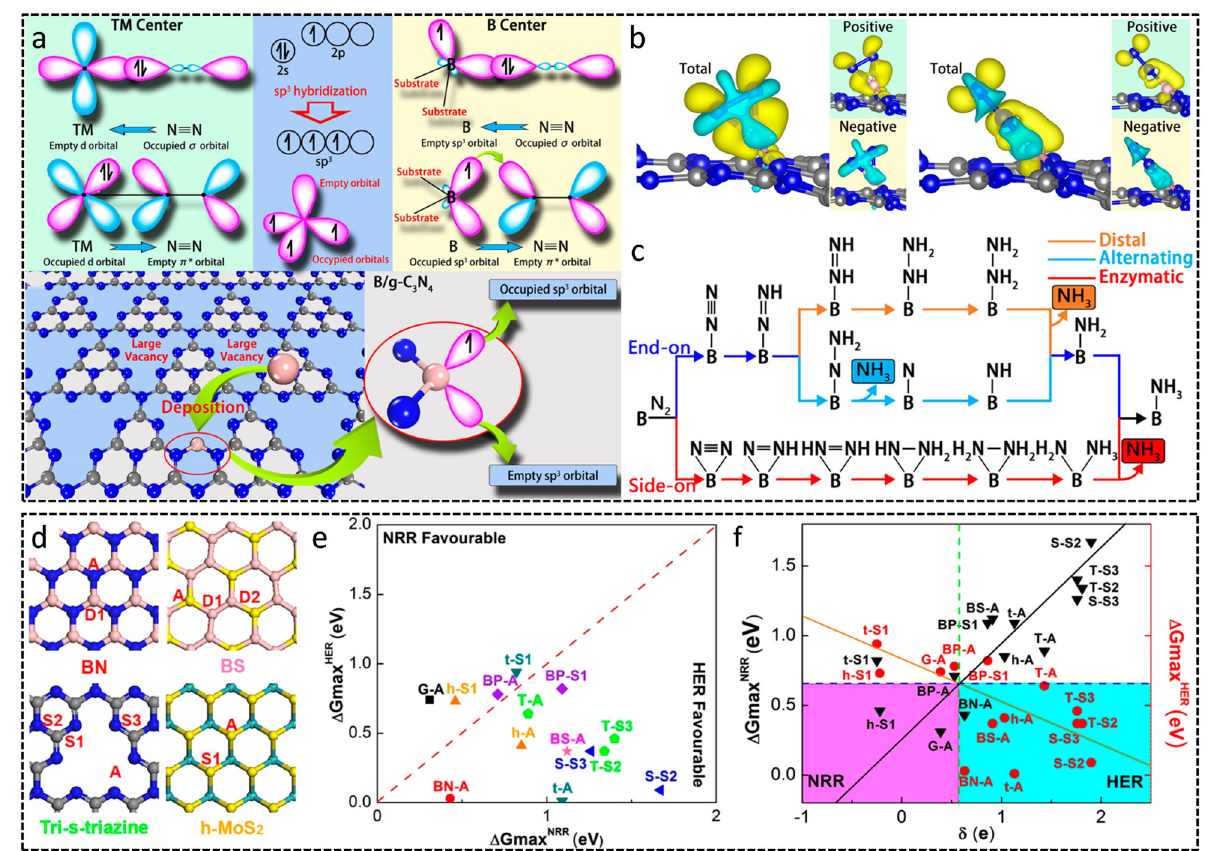
Fig. 8 B-decorated 2D materials for NRR. a Simpli fi ed schematic of orbitals of N 2 bonding to transition metals and the design concept of B/g- C 3 N 4 as a photocatalyst for N 2 fi xation. b Difference charge density of B/g-C 3 N 4 with the adsorption of N 2 via side-on and end-on patterns. c Schematic depiction of distal, alternating, and enzymatic mechanisms for N 2 reduction to NH 3 ( a – c are reproduced with permission